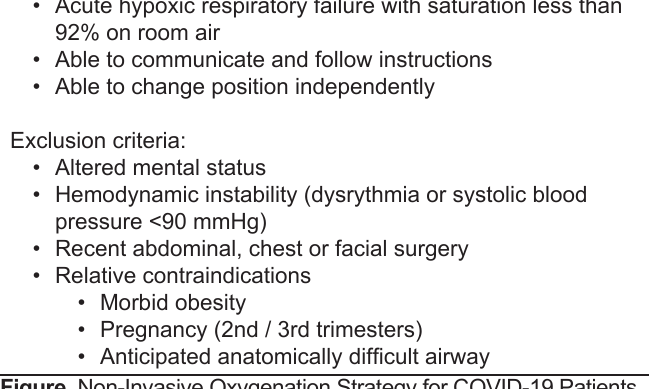
Figure. Non-Invasive Oxygenation Strategy for COVID-19 Patients with Acute Respiratory Distress. Inclusion and exclusion criteria based upon the recommendations from the Intensive Care Society (United Kingdom) and designed specifically for patients with hypoxic respiratory failure. mmHg, millimeters of